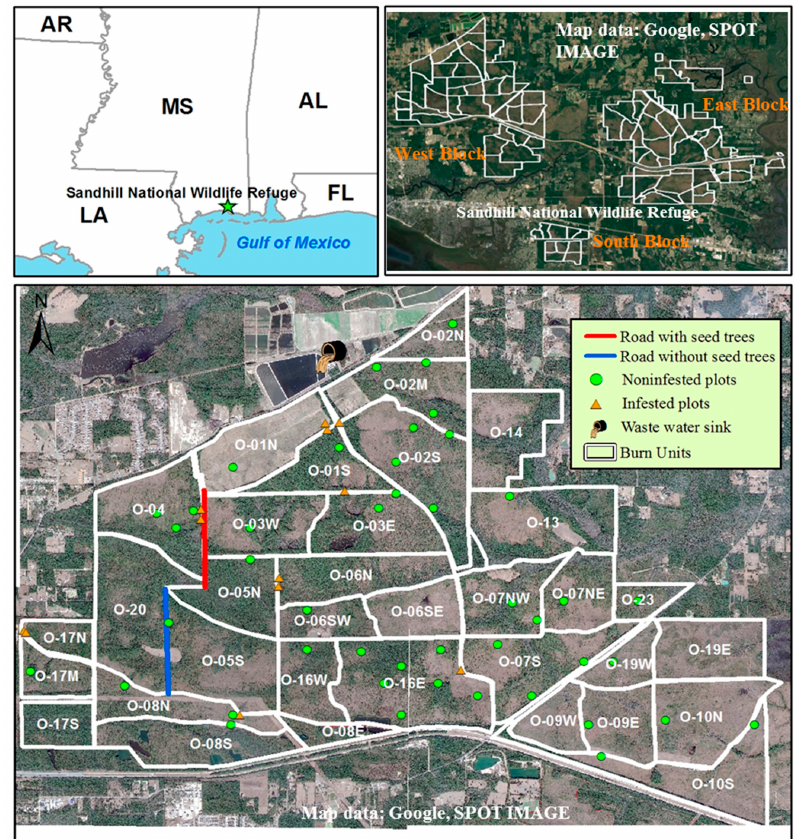
Figure 1. Map of Mississippi Sandhill Crane National Wildlife Refuge (MSCNWR) west block, showing the burn bunts, selected edges, and the locations of sample plots.